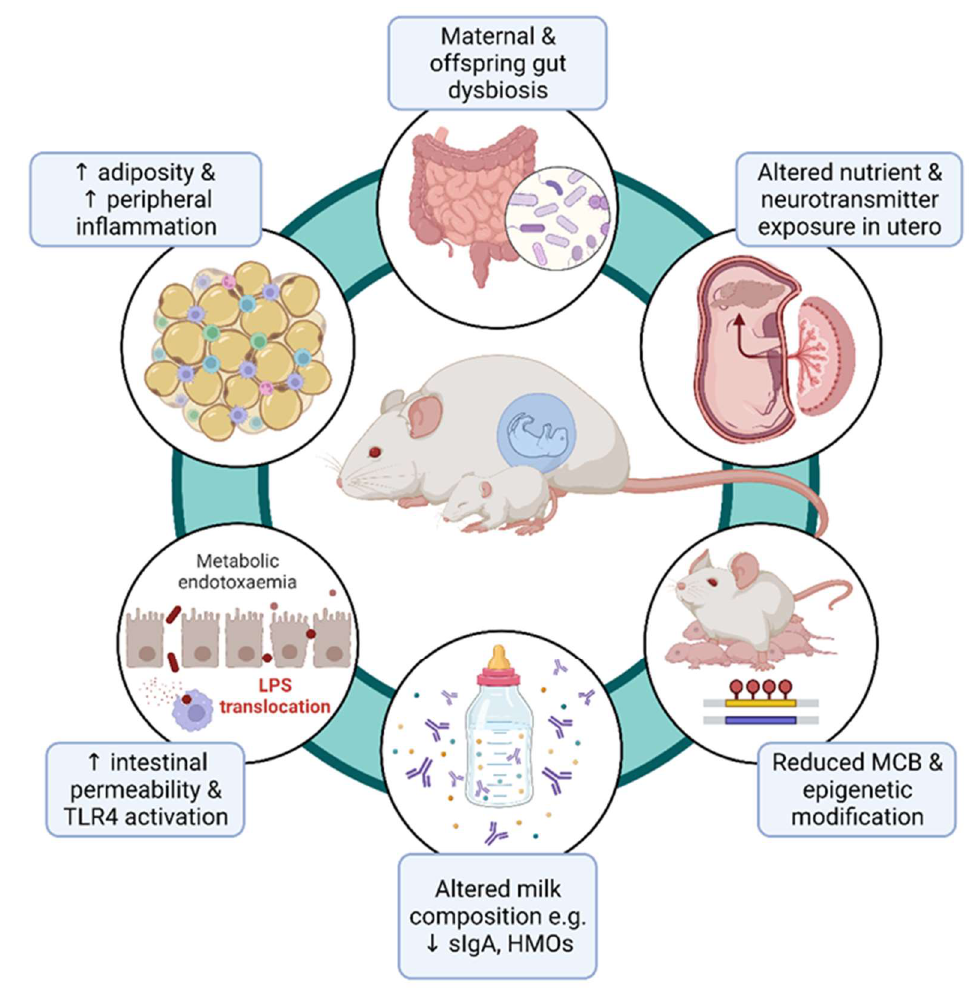
Figure 1. Summary of the putative mechanisms by which maternal obesity is thought to influence the course of offspring neurodevelopment. MCB, Maternal care behaviour; sIgA, secretory immunoglobulin A; HMOs, human milk oligosaccharides; TLR4, toll-like receptor 4. Seminal studies in rodent [10] and nonhuman primate (NHP) [11] offspring first ob- served the deleterious effects of maternal peripartum high-fat diet feeding on the offspring brain and behaviour (Table 1). In rats, it was shown that the expression of CD11b, a marker of macrophages and CNS-resident microglia, and TLR4 was significantly upregulated in the juvenile offspring of obese dams fed a diet high in saturated fat [10]. TLR4 activation is required for robust pro-inflammatory responses to bacterial endotoxin, but it also mediates central inflammatory signalling and alters brain metabolism. In addition, the basal level of IL-1 β protein was significantly elevated in the hippocampus and periphery (liver) of both juvenile and adult offspring of high fat diet (HFD)-fed dams compared to offspring of controls. These inflammatory changes in HFD-exposed offspring were associated with an increased anxiety in the elevated plus maze. Moreover, Sullivan et al. (2010) linked changes in maternal HFD (mHFD) consumption during gestation with an increased anxiety-like behaviour in juvenile female NHP offspring [11]. This was also accompanied by perturba- tions to the serotonergic system, including decreased cerebrospinal fluid levels of serotonin. These studies paved the way for future animal models investigating the underlying